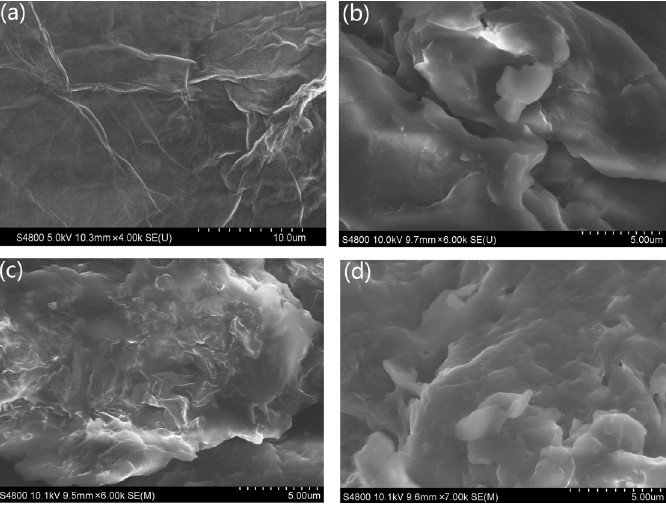
Figure 3. SEM images of the surface: ( a ) GO; ( b ) PU(80%PEG); ( c ) PU(80%PEG)/GO; ( d ) PU(92%PEG)/GO.